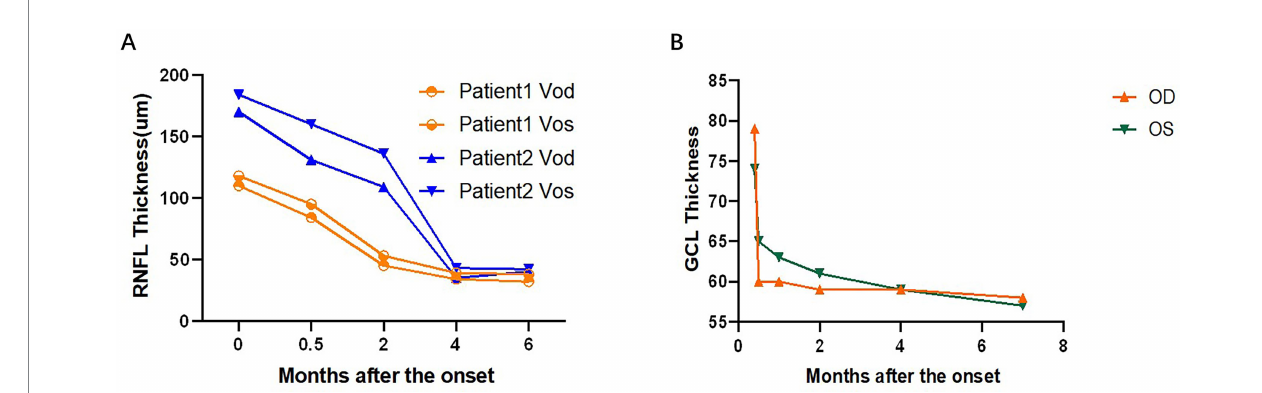
FIGURE 4 Line graph of the thickness of the development of RNFL and GCL in the course of the disease progression during the patient’s follow-up of 6 months. GCL, retinal ganglion cell